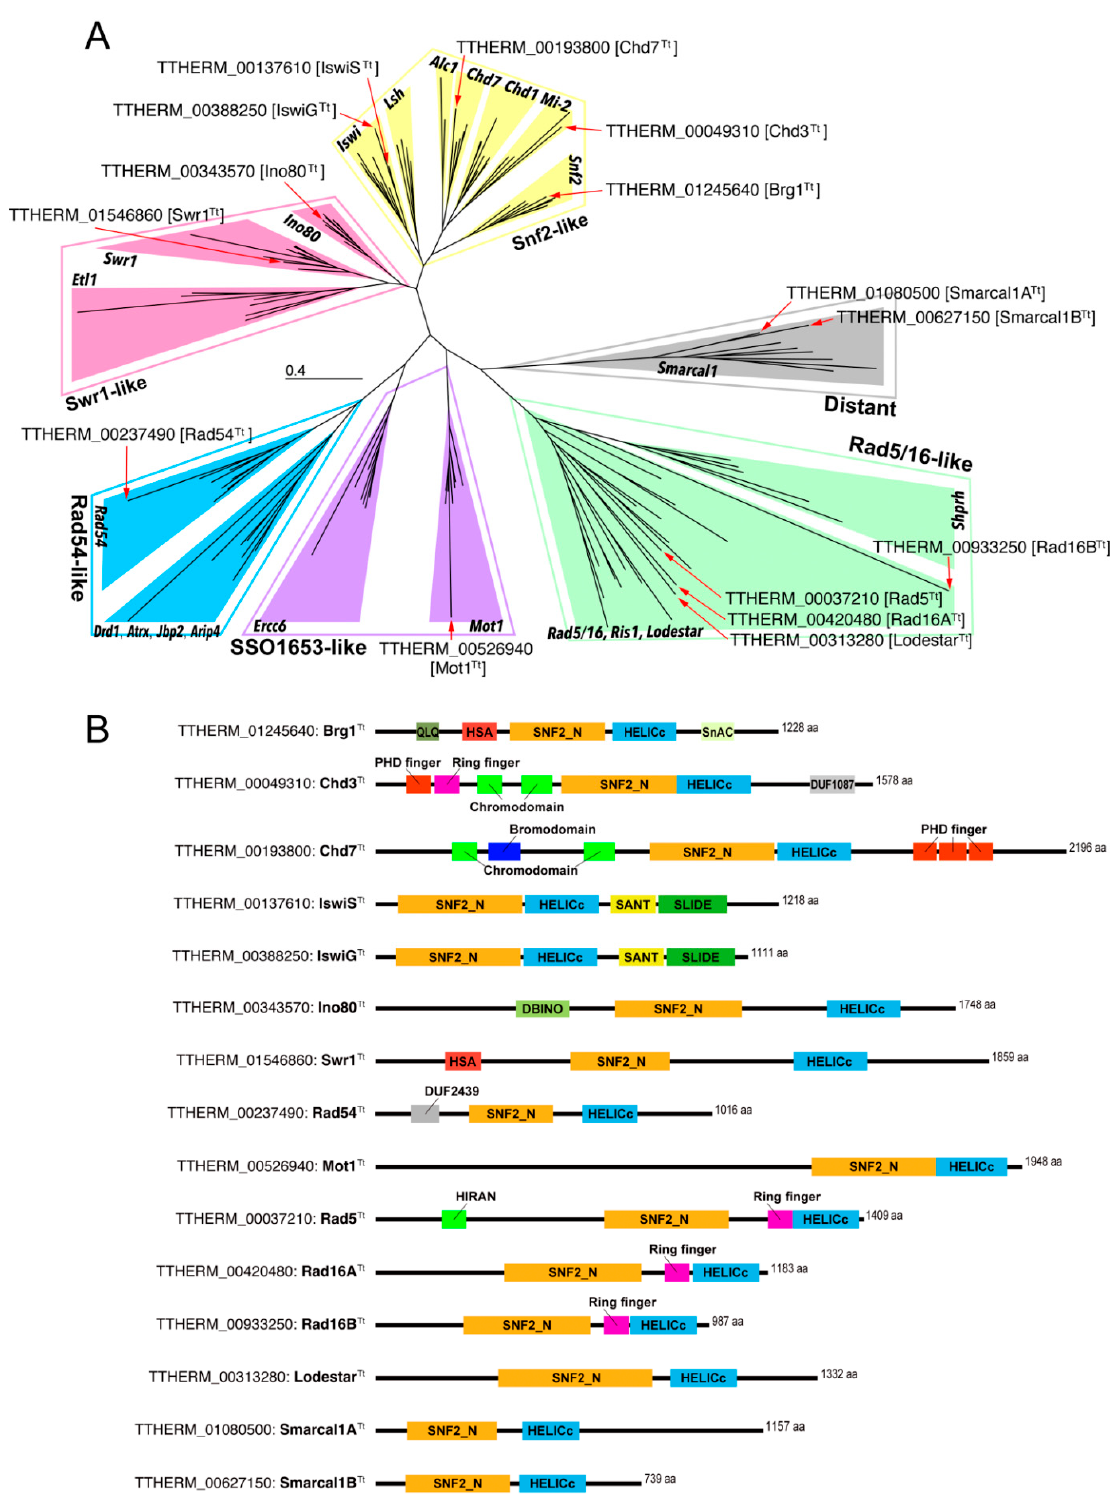
Figure 1. ( A ) An unrooted ML phylogenetic tree based on conserved amino acid sequences cor- responding to the SNF_N and HELICc domains. Details including bootstrap values and proteins employed are displayed in Figure S3. Open boxes represent six general groupings. Bold oblique lines indicate subfamilies; ( B ) schematic diagram of the predicted domain/motif structure of 15 Snf2 family proteins found from Tetrahymena